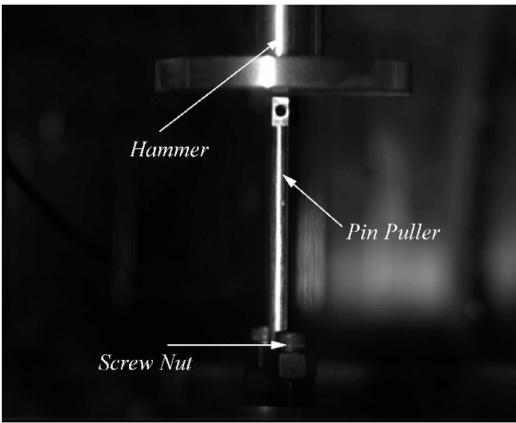
Figure 5. Drop-weight test tooling.